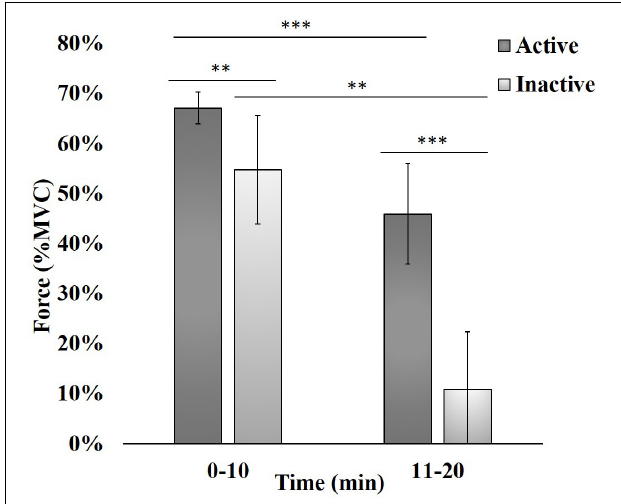
FIGURE 2 | Force produced during intermittent handgrip contractions while physically inactive and active subjects attempted to attain 100% MVC. Each bar represents an average of 60 consecutive trials, expressed as the Mean (bar height) ± Standard Error to the Mean (SEM; error bar). ∗∗ p < 0.01, ∗∗∗ p <